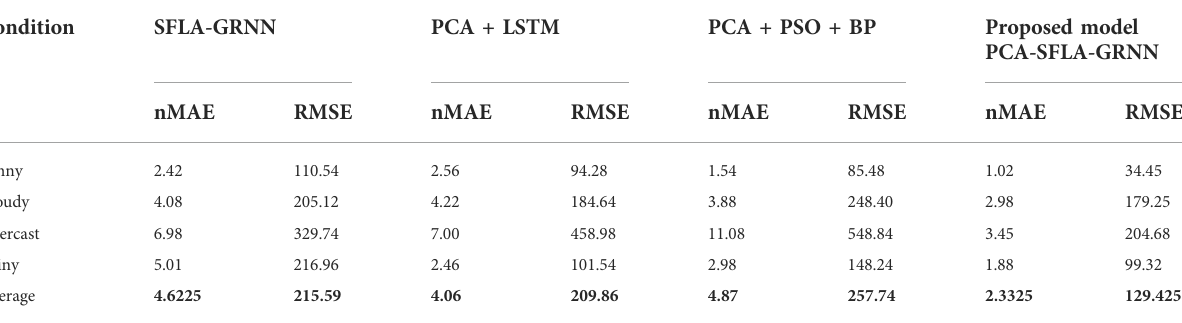
TABLE 3 Comparison of